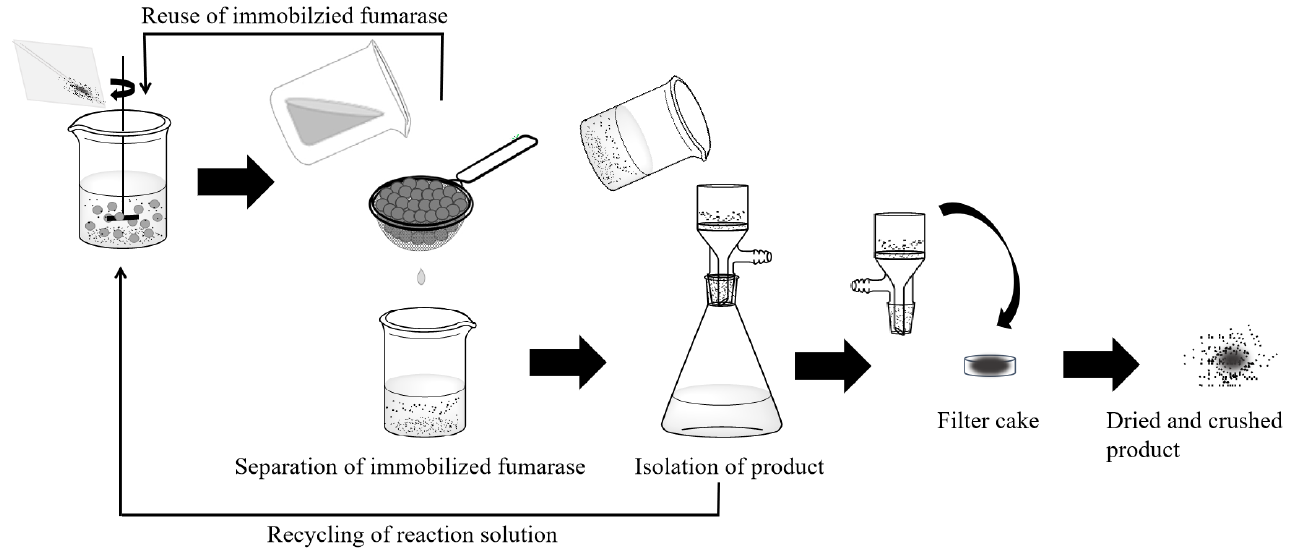
Figure 8. Scheme of recycling of immobilized fumarase and isolation of calcium L -malate crystals.